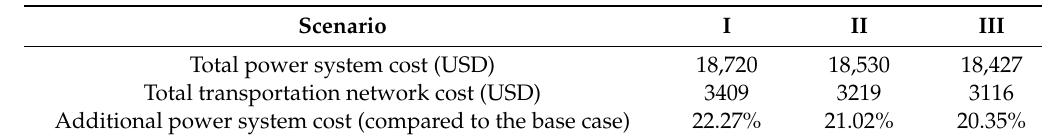
Table 4. Comparison between total power systems cost and transportation network cost for different scenarios in the absence of PHEVs.